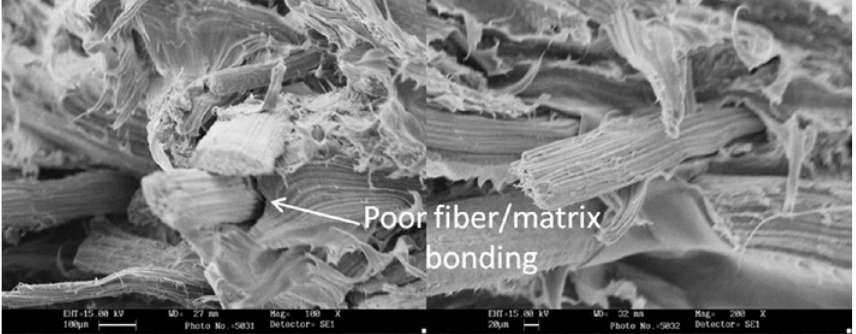
Figure 12: SEM micrograph of the tensile fracture surface of sample S2 at × 100 and × 200 magnification.